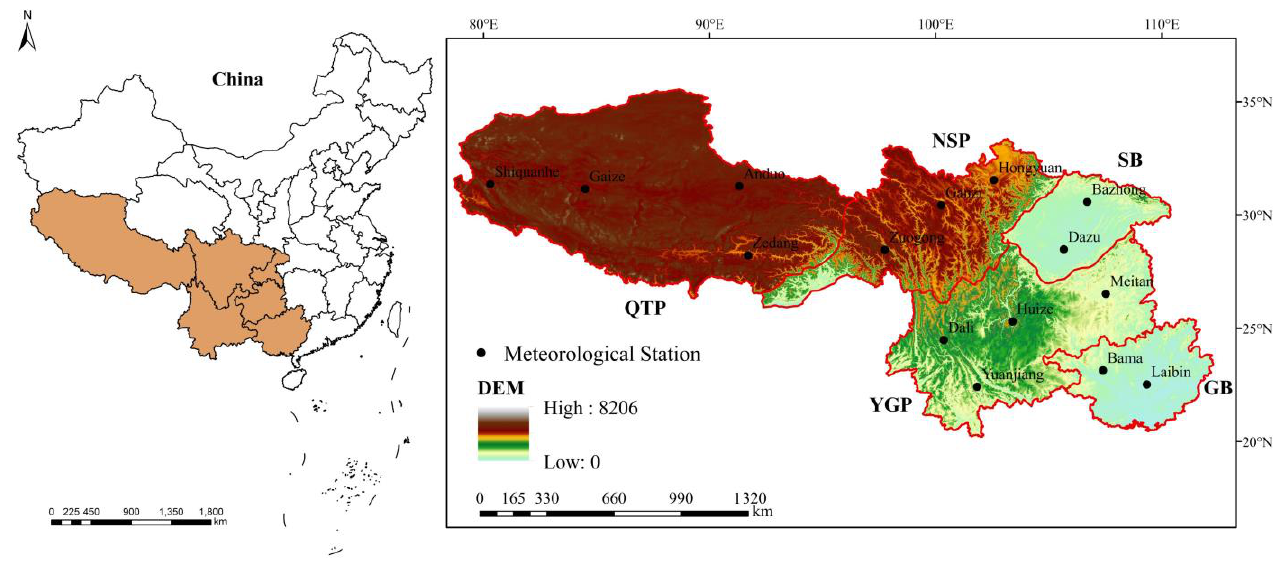
Figure 1. Geographic locations of the representative meteorological stations and five zones in Southwest China. Table 1. Annual means of the main meteorological parameters at each station during